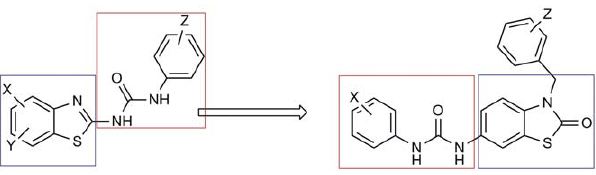
Figure 10. Scaffold morphing observed in the hit was used as one of the selection criteria. The diversification is achieved by having different attachment points and thus different geometrical diversity in the virtual space of its